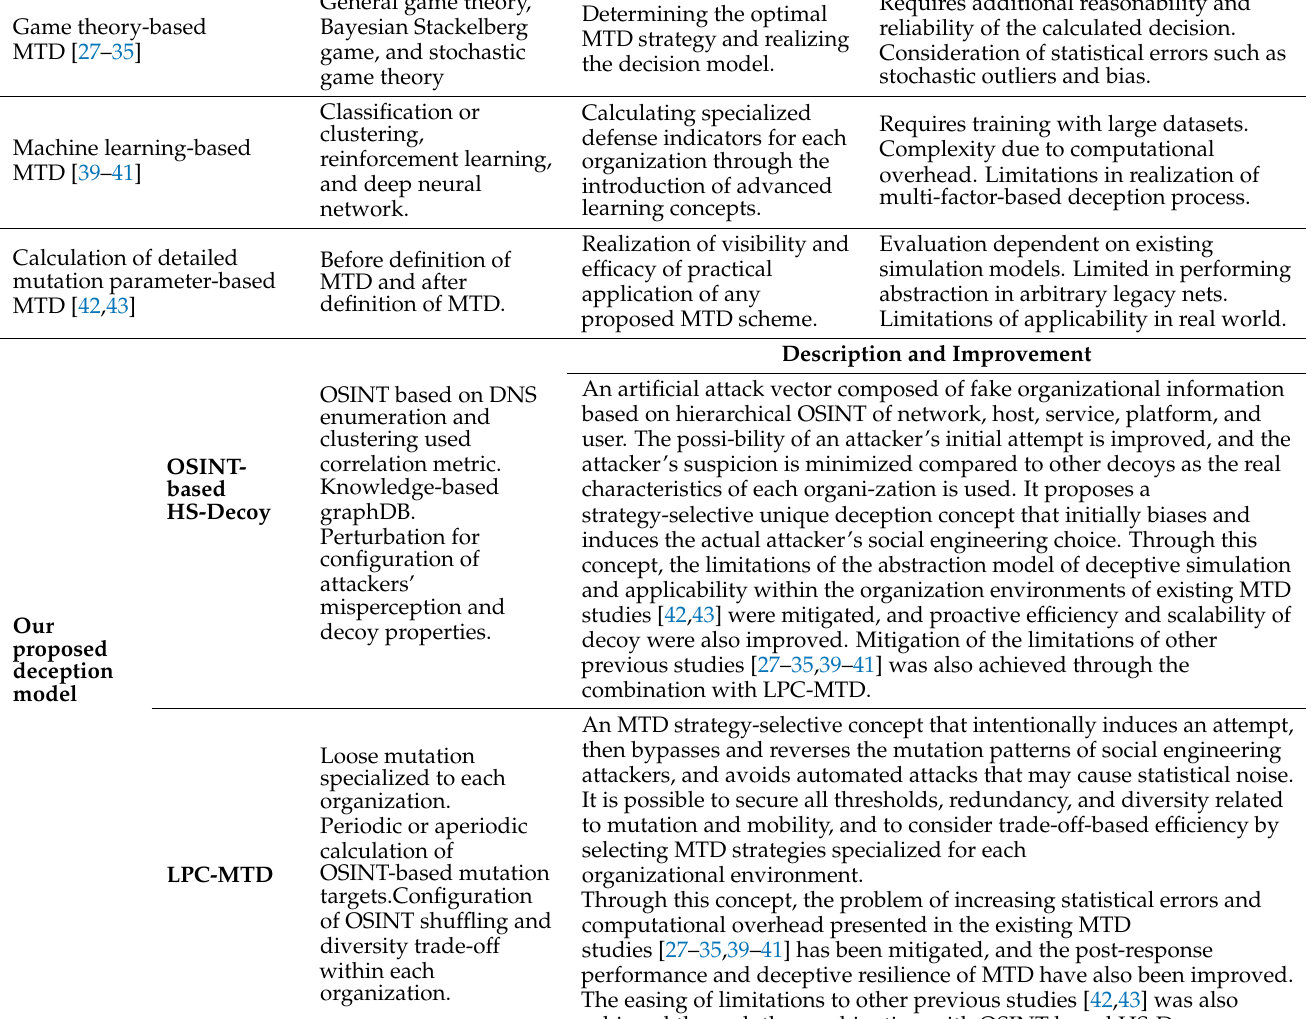
Table 1. Taxonomy of existing moving target defense (MTD) and decoy-based deception research and proposed scheme.